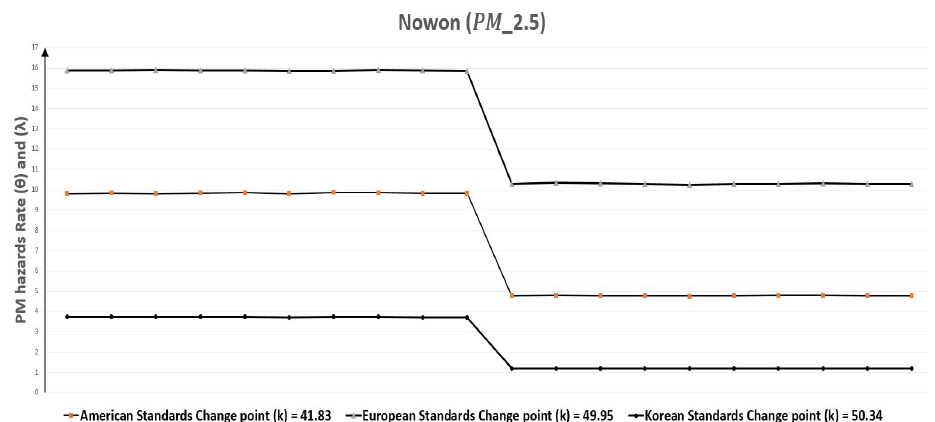
Figure 20. Nowon (Seoul, South Korea) monthly polluted days before and after the change point due to PM 2.5 .